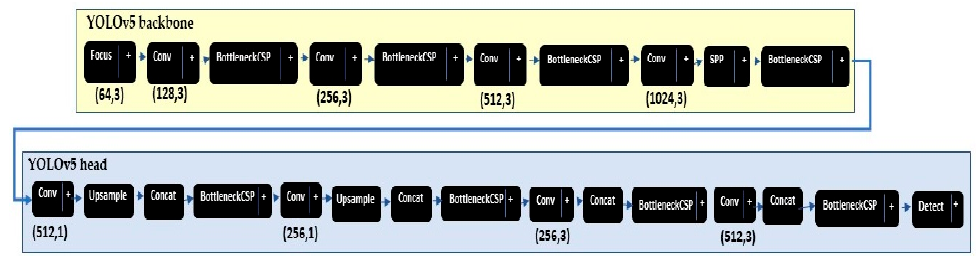
Figure 4. YOLOv5 small model as displayed by Netron app [77].